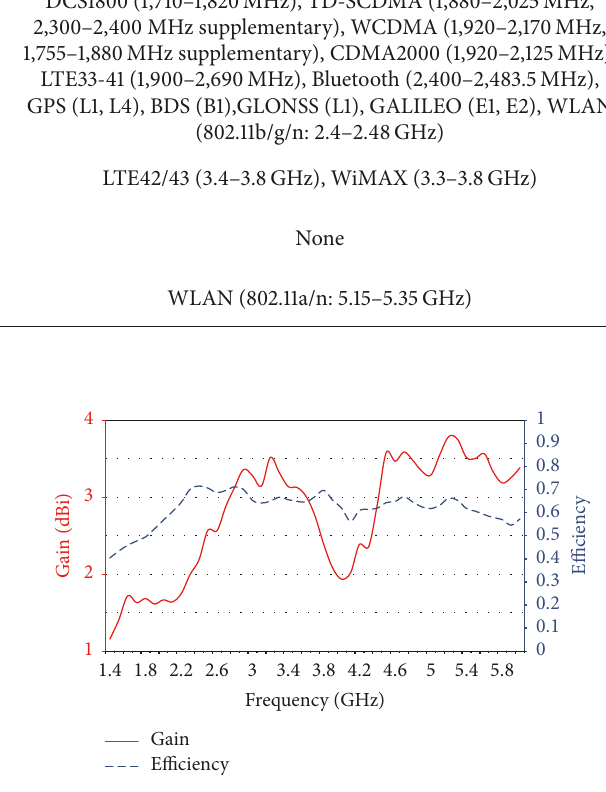
Figure 12: Measured gain and efficiency curves.